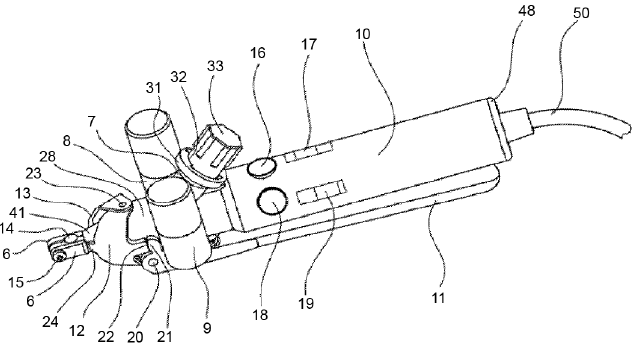
Figure 2. This image shows the heating or cooling module (7), vibration module (8), and hammering module (9). Source: [32].